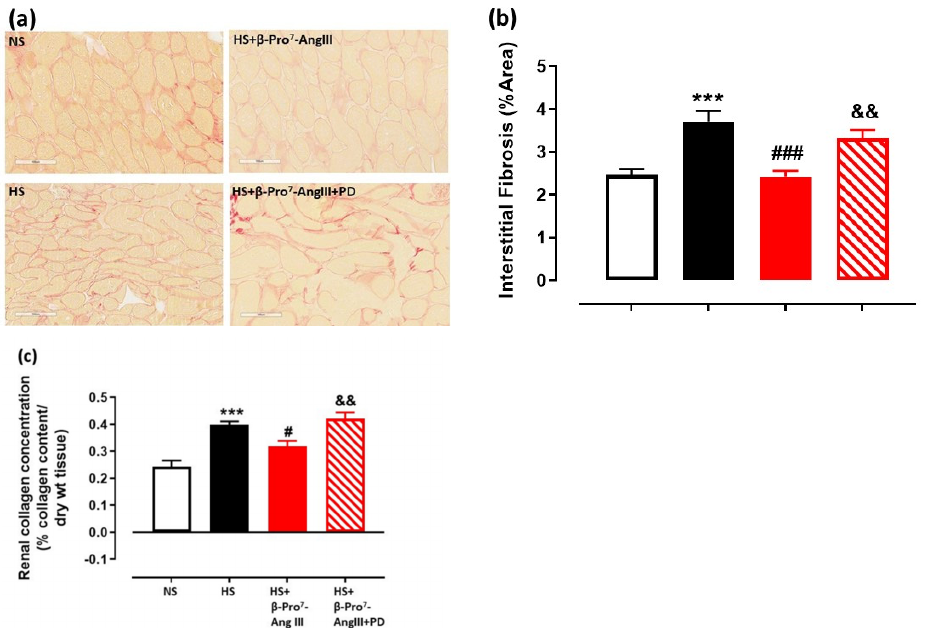
Figure 2. ( a ) Representative images for interstitial fibrosis stained with picrosirius red (indicated by red) in kidney sections obtained from male FVB/N mice fed on a normal salt (NS, 0.5% NaCl) diet or mice fed on a high salt (HS, 5% NaCl) diet in the presence or absence of β -Pro 7 -AngIII (0.1 mg/kg/day) +/- PD123319 (1 mg/kg/day). Scale bar for all images = 50 µ m. ( b ) Group data of % area of interstitial fibrosis in kidney sections. ( c ) Total tissue collagen measured by hydroxyproline assay in kidney tissue from same animal groups in which picrosirius red staining was performed (n = 7–8 per group). All data are expressed as mean ± s.e.m. *** p < 0.001 vs. sham; # p < 0.05, ### p < 0.001 vs. HS; && p < 0.01 vs. HS+ β -Pro 7 -AngIII, determined by One-Way ANOVA with Tukey correction for multiple